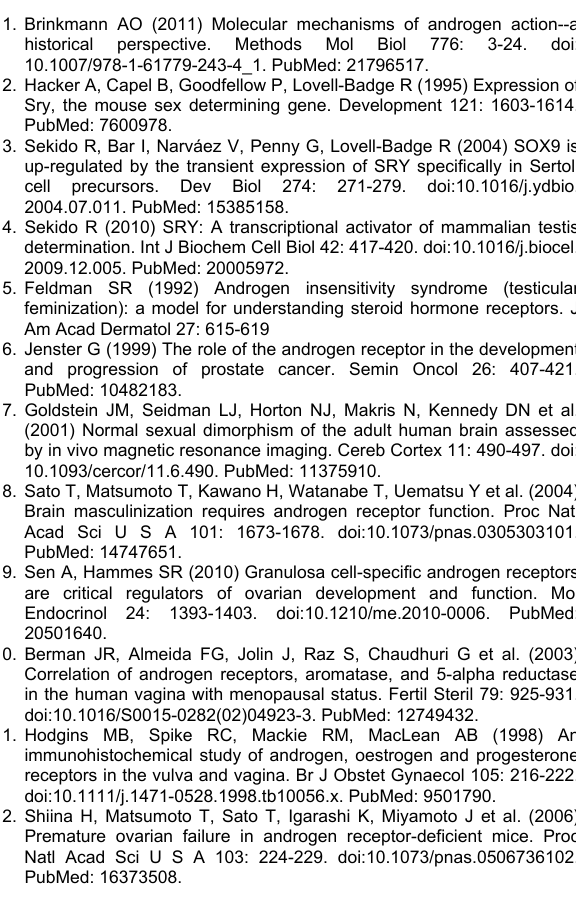
Luciferase kinetics depends on route of injection. Comparison of the time kinetics of bioluminescent signal from ARE-Luc mice injected with 150mg/kg luciferin substrate via either the i.p. or s.c. route.